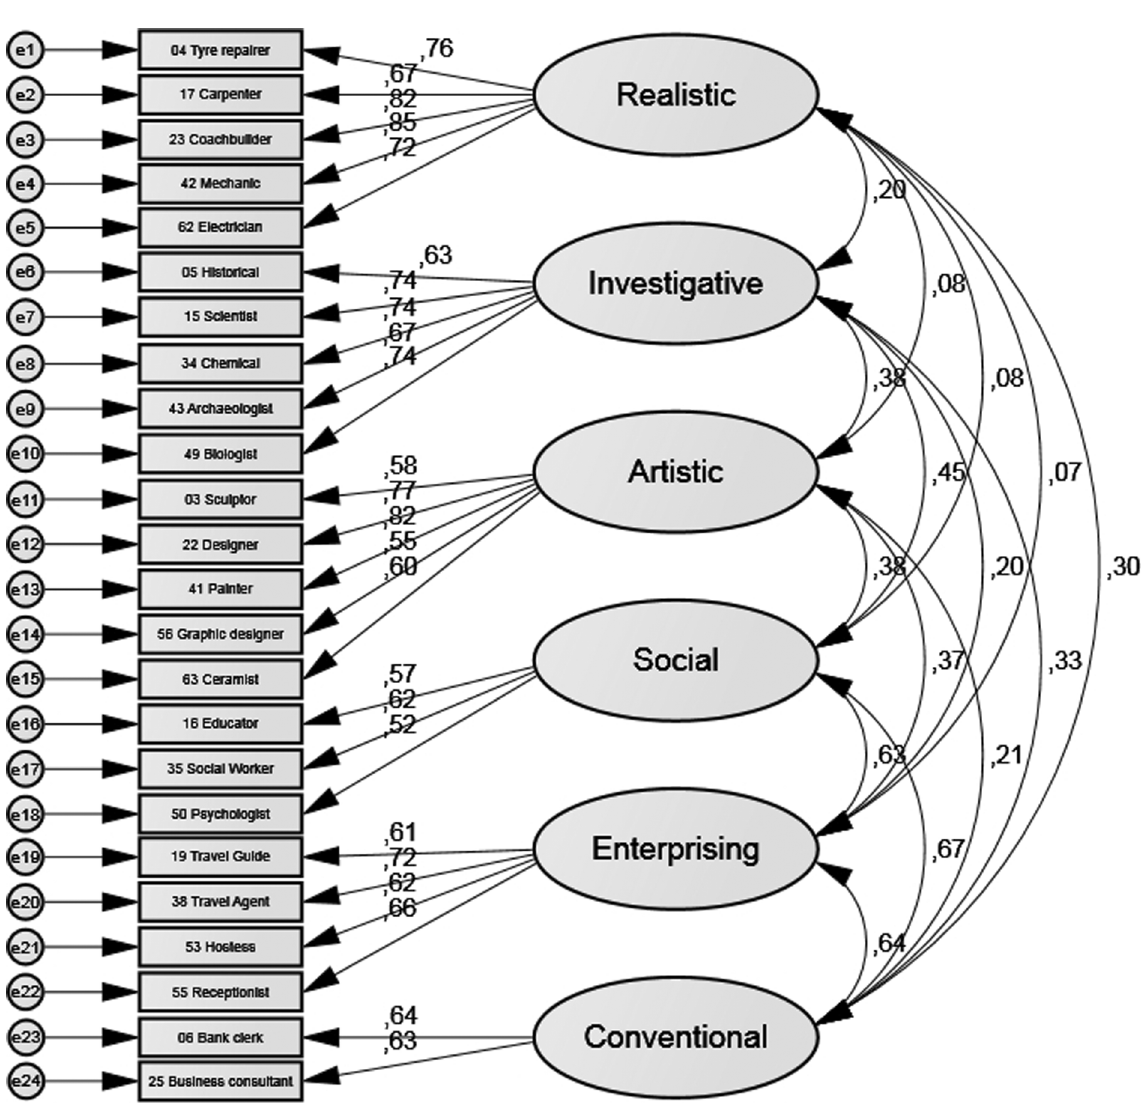
Figure 6. Standardised estimates for the RIASEC